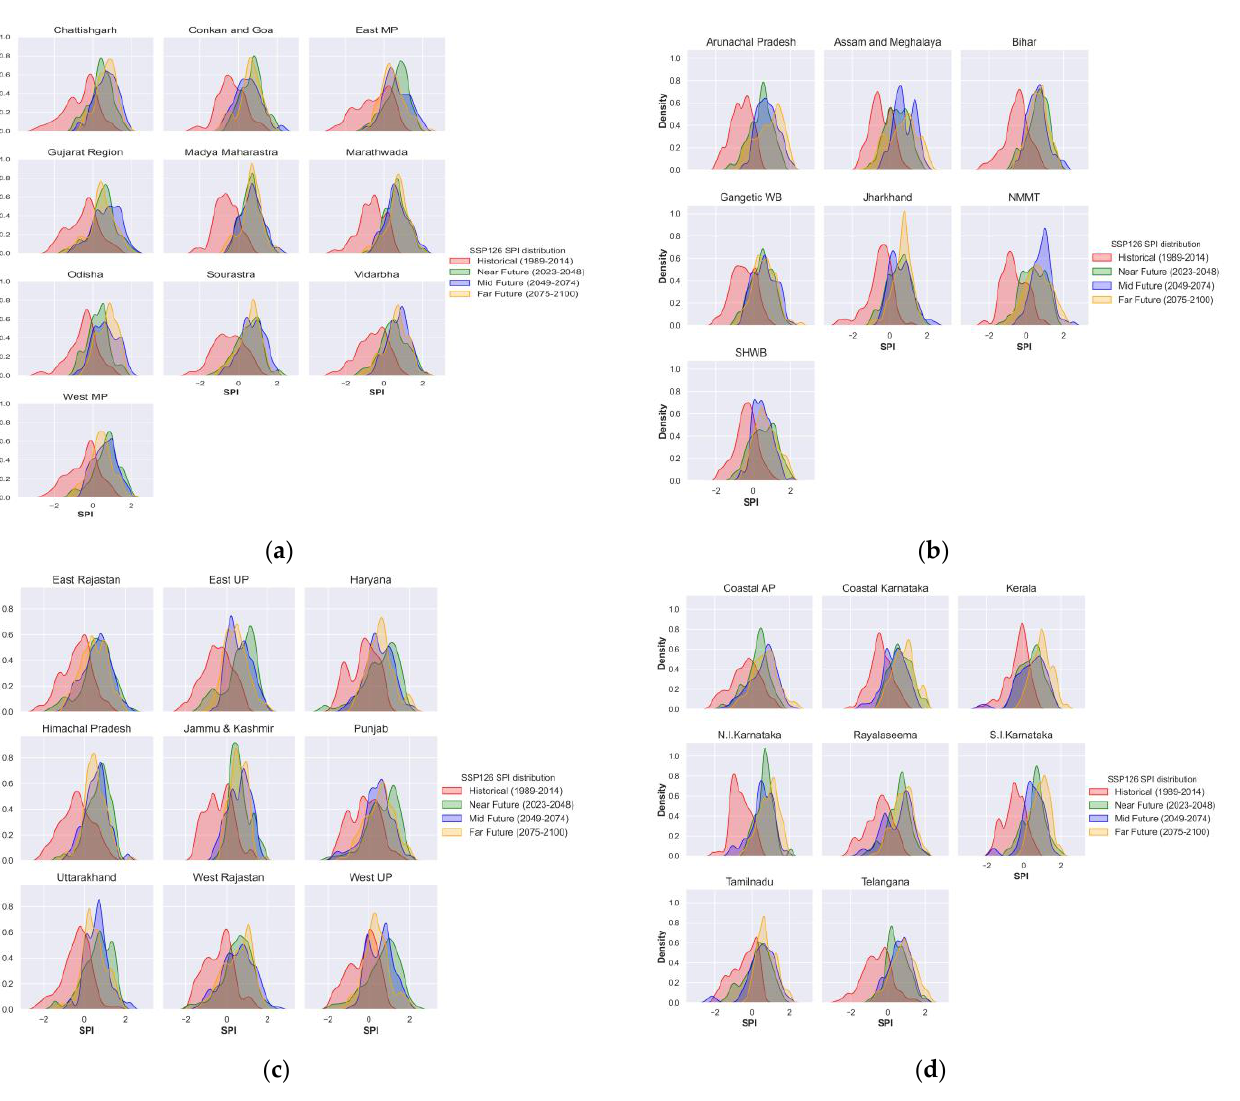
Figure 9. CMIP6 SSP scenarios 12-month Standard Precipitation Index (SPI) boxplot at homogene- ous region level ( a ) Central India, ( b ) East and Northeast India, ( c ) Northwest India, and ( d ) South Peninsula India for near, mid, and far future.